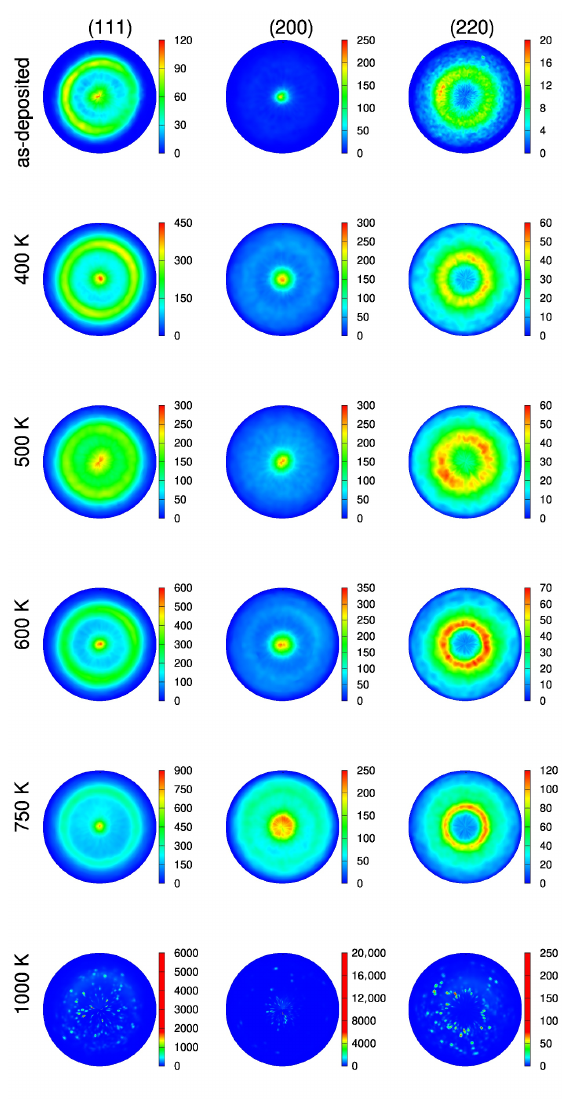
Figure 11. (111), (200) and (220) pole figures obtained by XRD for the “es” side of the CYS04 film heated up to different